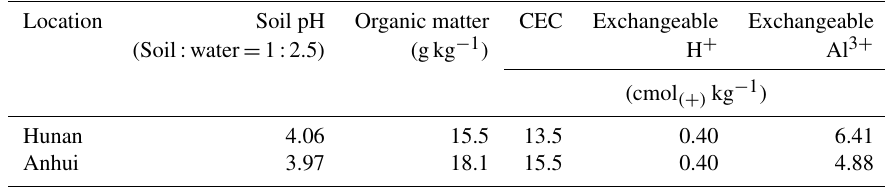
Table 1. Some initial properties of the two Ultisols from Hunan and Anhui. Location Soil pH Organic matter CEC Exchangeable Exchangeable (Soil:water = 1:2.5) (gkg − 1 ) H + Al 3 + (cmol ( + ) kg − 1 ) Hunan 4.06